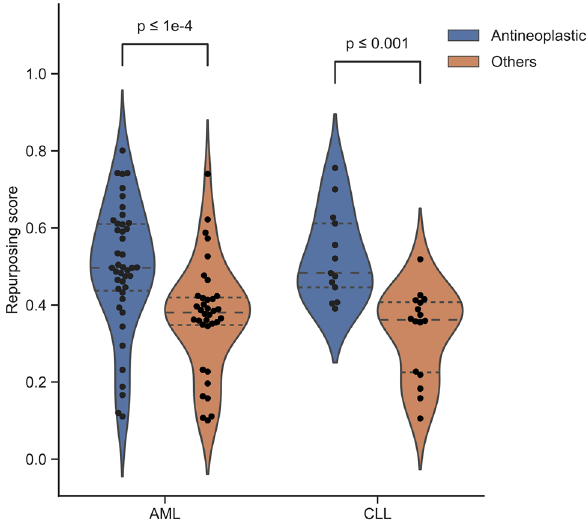
Figure 5. Distribution of DrugRepo scores for drugs with similar therapeutic uses (antineoplastic) vs other drugs.